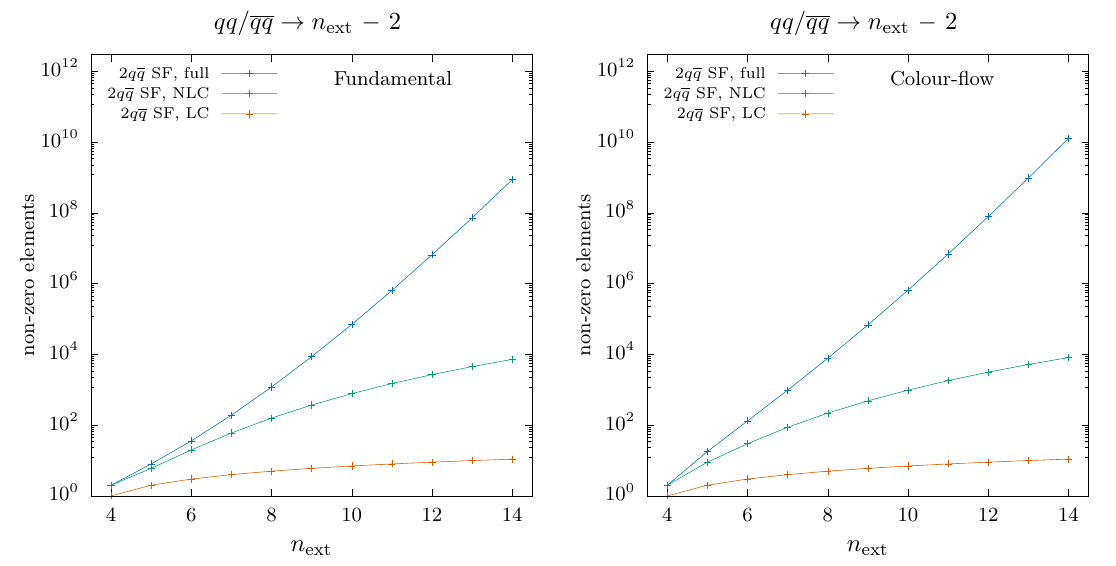
Figure 6 . Number of non-zero elements in the colour matrix at LC (red), NLC (green) and full colour (blue) for qq/qq initial state in fundamental (left) and colour-flow decomposition (right) for the two-quark-pair same-flavour channel